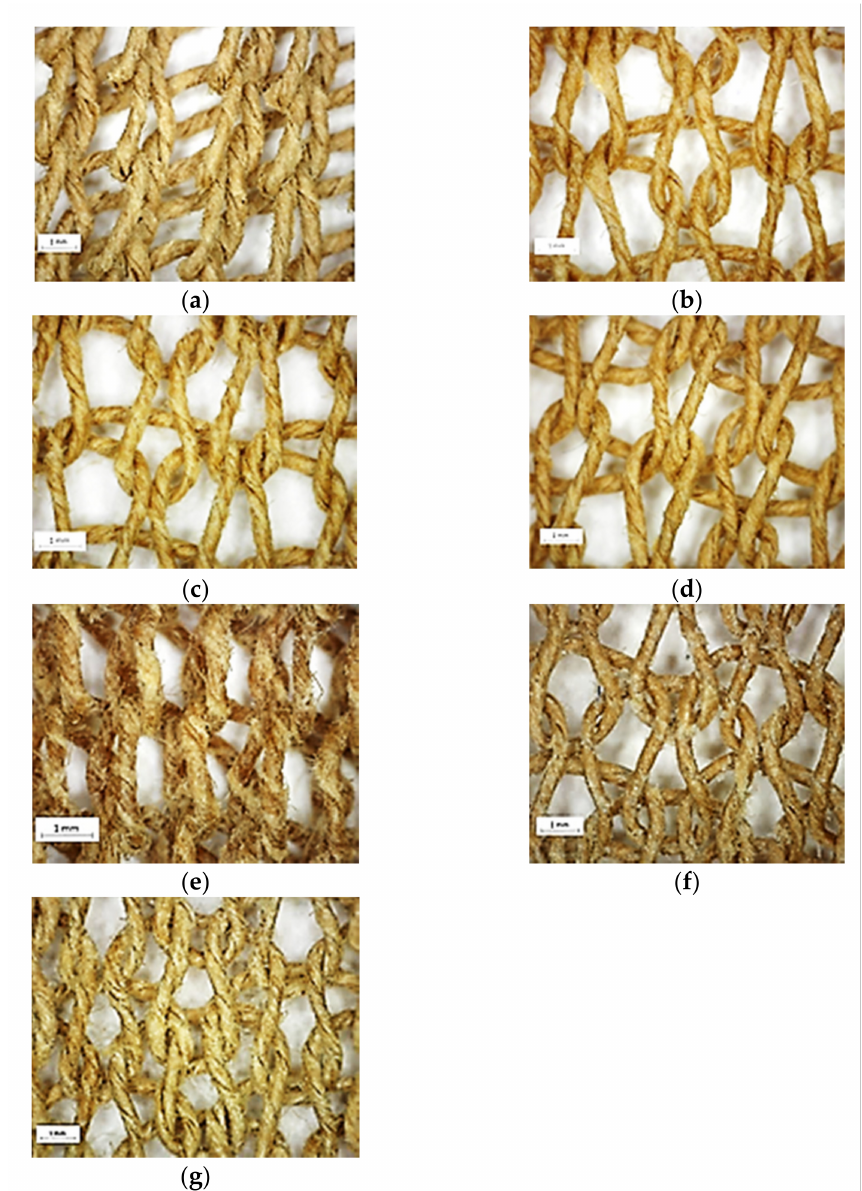
Figure 9. Microscopy pictures of the knitted samples. ( a ) Untreated yarn; ( b ) 102-finished yarn; ( c ) Tubingal RGH finished yarn; ( d ) Ultratex UHS finished yarn; ( e ) Glycerol finished yarn; ( f ) Wax finished yarn; ( g ) Soap finished